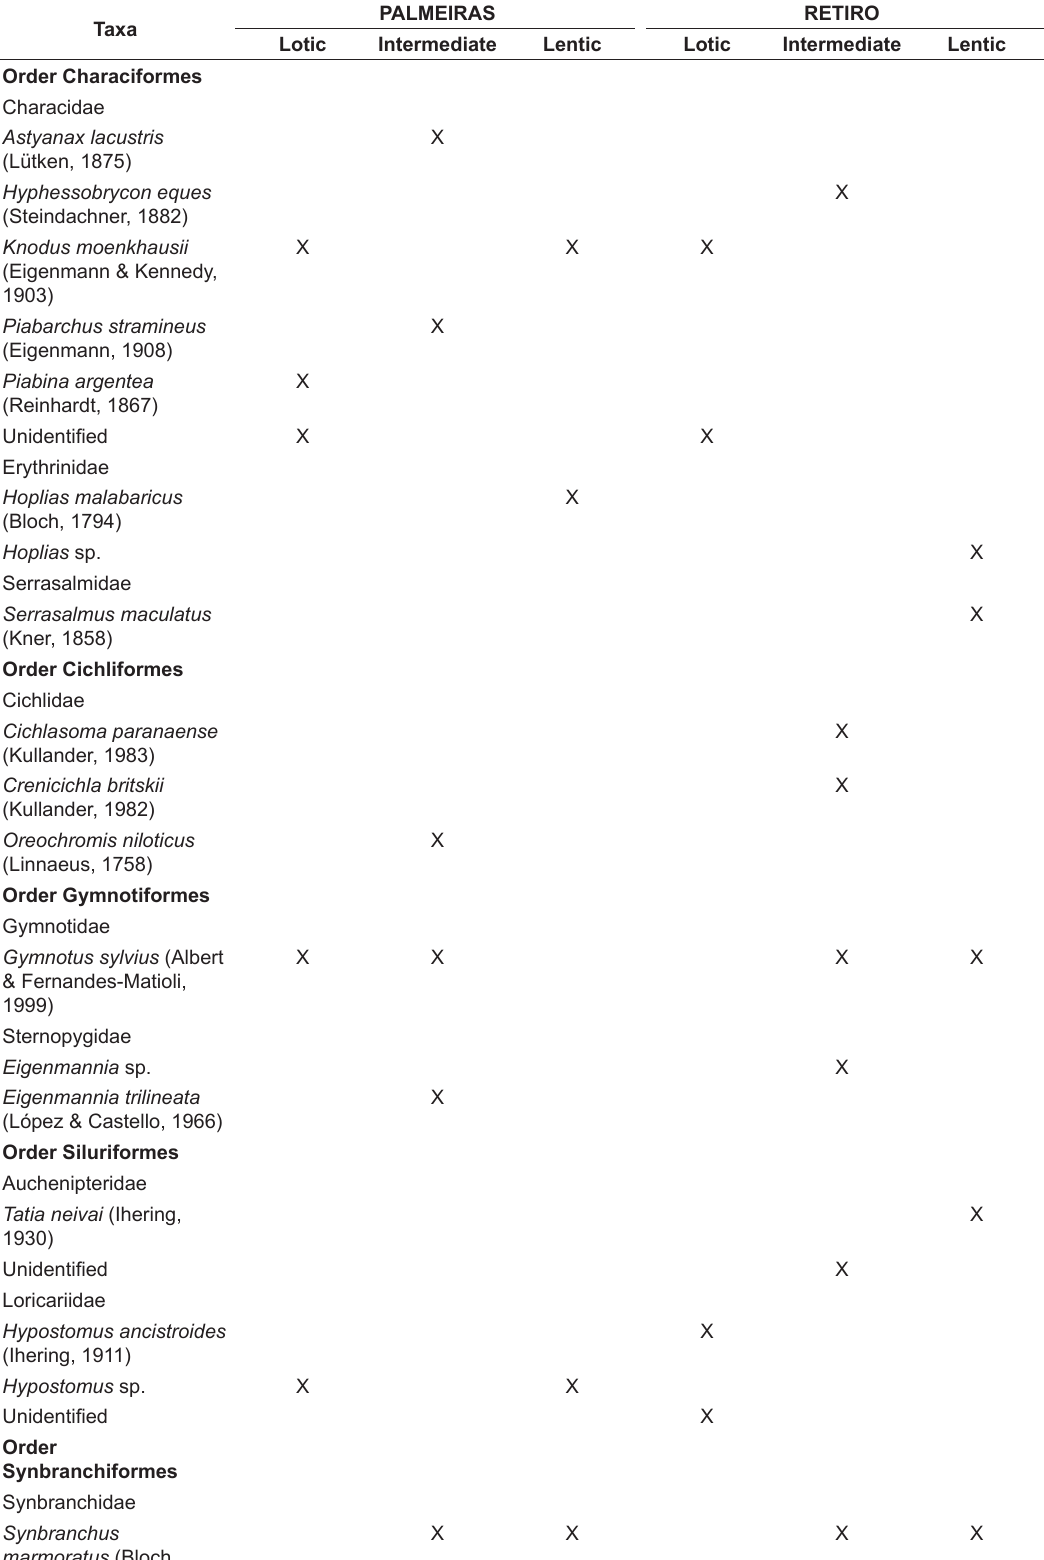
Table 4. Taxonomic list of fish fauna associated to macrophyte banks in the distinct compartments of Palmeiras and Retiro SHPs reservoirs, Sapucaí-Mirim River (SP,